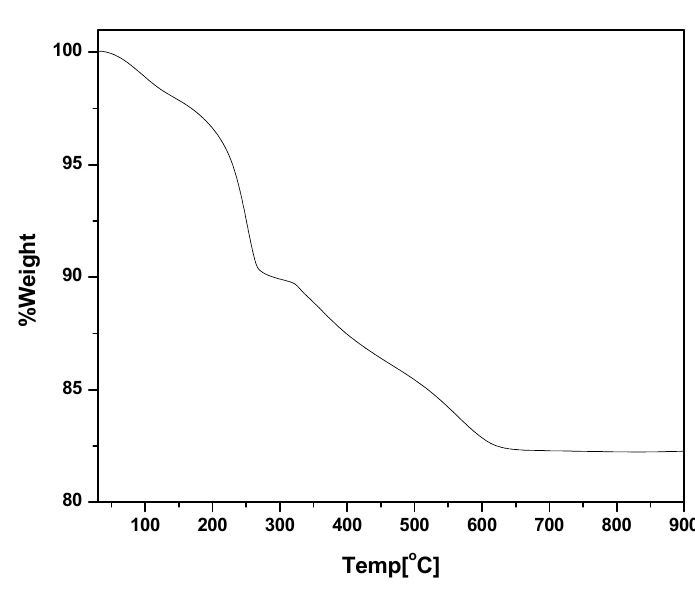
Fig. 3 TGA analysis showing the thermal behavior of (NH 4 ) 0 . 5 Mn 1 . 25 (H 2 O) 2 [BP 2 O 8 ] · 0.5H 2 O.